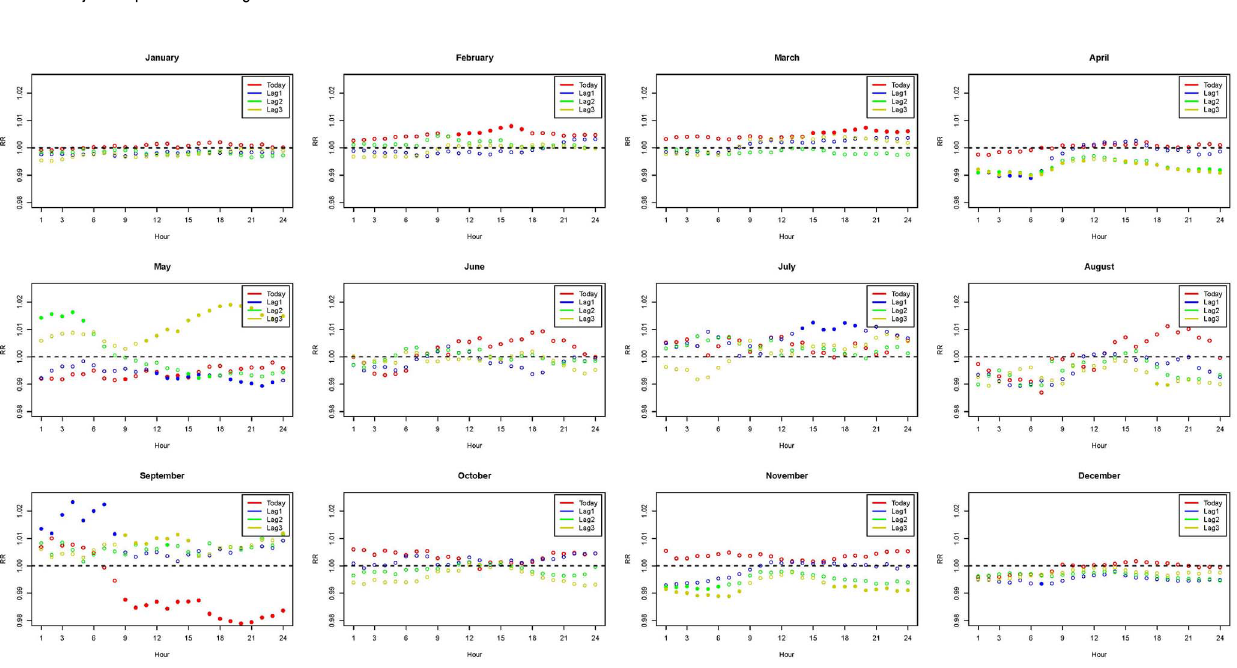
Figure 2. Distribution of hourly relative risk in the elderly population adjusted for O 3 . (Abbreviations: max, maximum; min, minimum; RR, relative risk; diff, daily range; T 5am , temperature at 5 am; T 8am , temperature at 8 am). Models were adjusted for daily mean of ozone exposure, city effects, calendar year, daily relative humidity, and holidays.